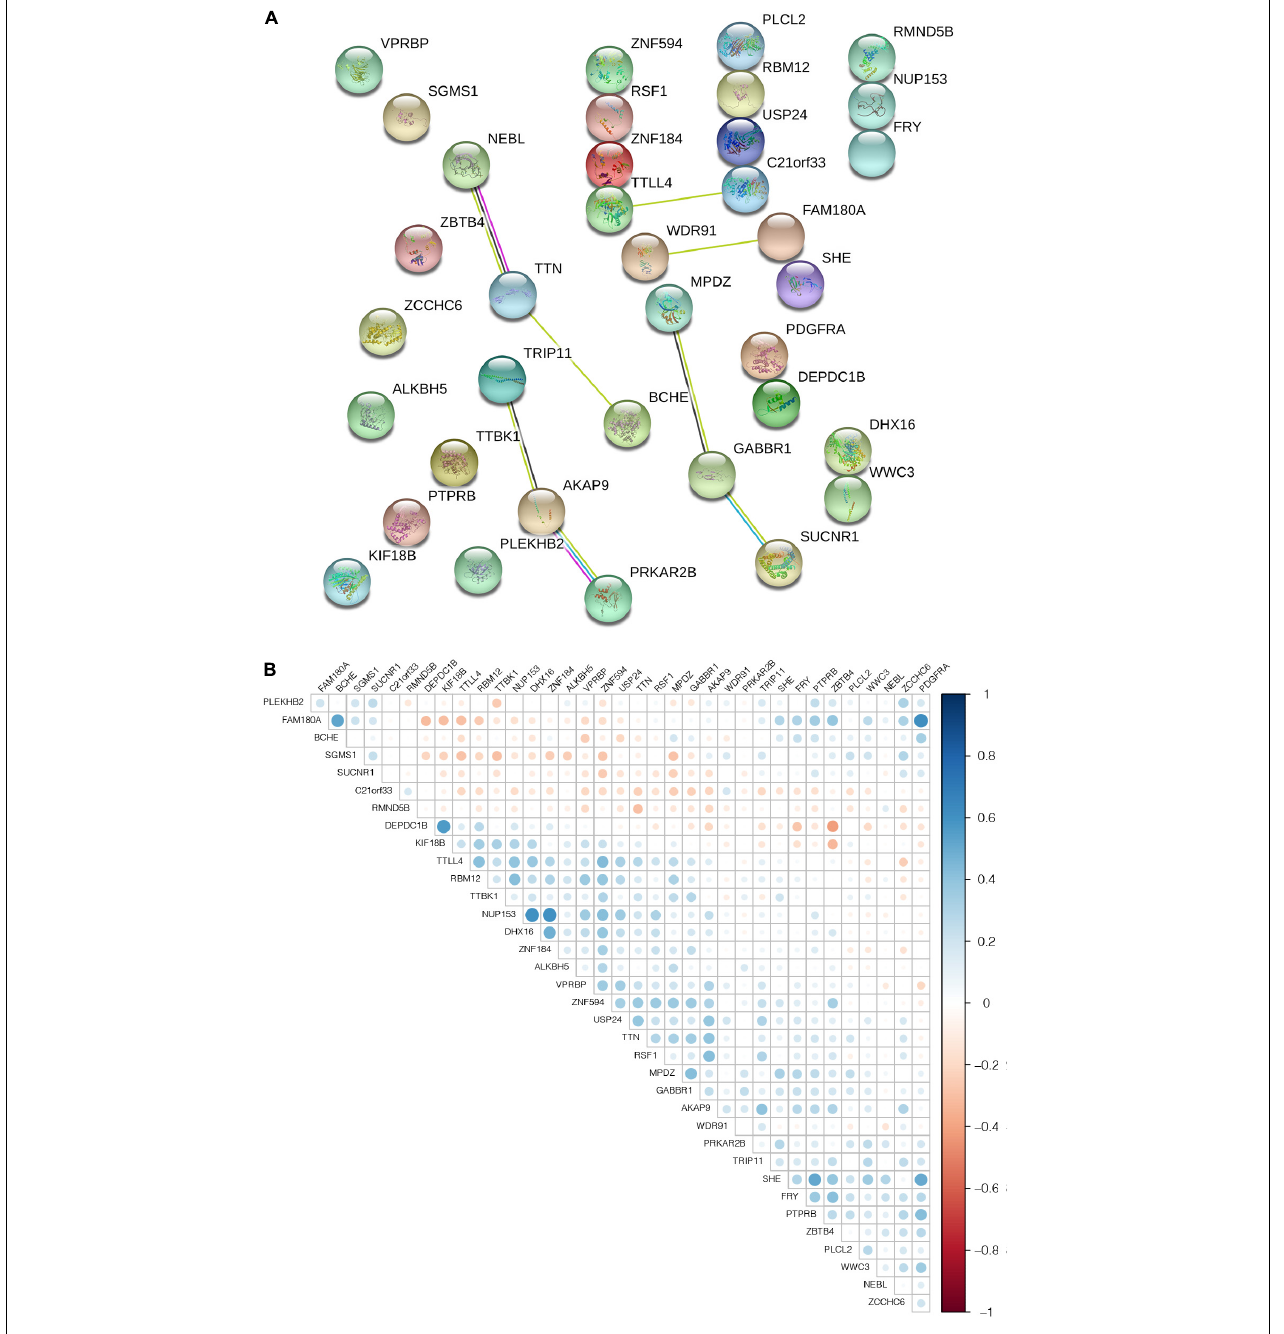
FIGURE 5 | The interaction and correlation among m 6 A-related genes. (A) PPI network was constructed to evaluate the interaction among m 6 A-related genes. (B) The Pearson correlation analysis was used to determine the correlation among m 6 A-related